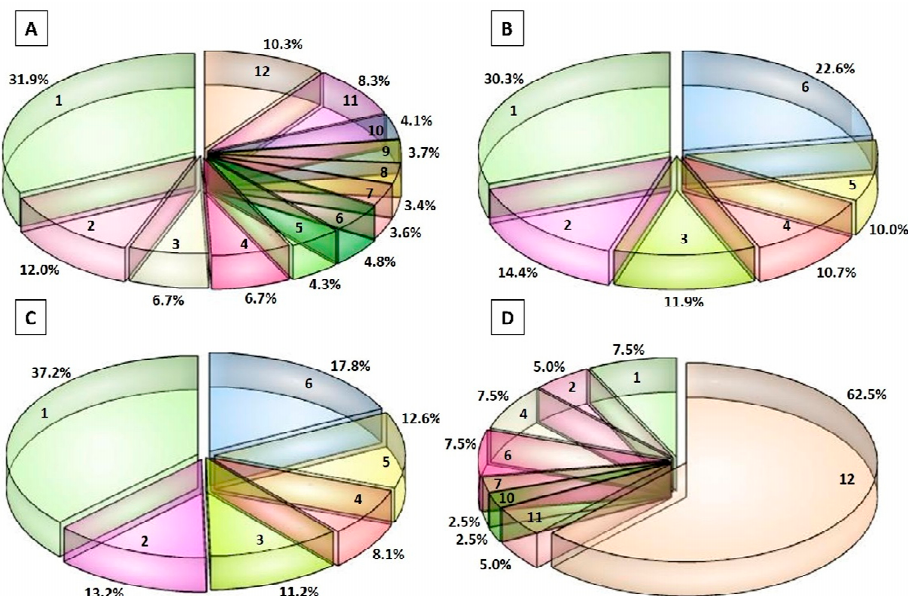
Figure 3. Frequency of identification of the peptides in the Parmigiano-Reggiano (PR) peptide fractions. ( A ) Frequency of identification of the peptides considering all of the 12 PR samples. ( B ) Frequency of identification of the peptides in the 6 PR samples belonging to the high-salt and high-fat group. ( C ) Frequency of identification of the peptides in the 6 PR samples belonging to the low-salt and low-fat group. ( D ) Frequency of identification of the bioactive peptides considering all of the 12 PR samples. The numbers from 1 to 12 or from 1 to 6 indicate the number of PR samples in which the peptides were identified. The percentage values are referred to the % of peptides found in the PR samples. For example, in Figure 3A, 31.9% of single peptides were found in an individual PR sample, whereas the 10.3% of peptides were common in all of the 12 PR samples.